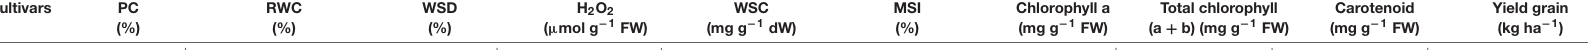
TABLE 5 | Comparison of the mean of the dual interaction of cultivar and irrigation on some studied traits of wheat in 2017–2018. Cultivars